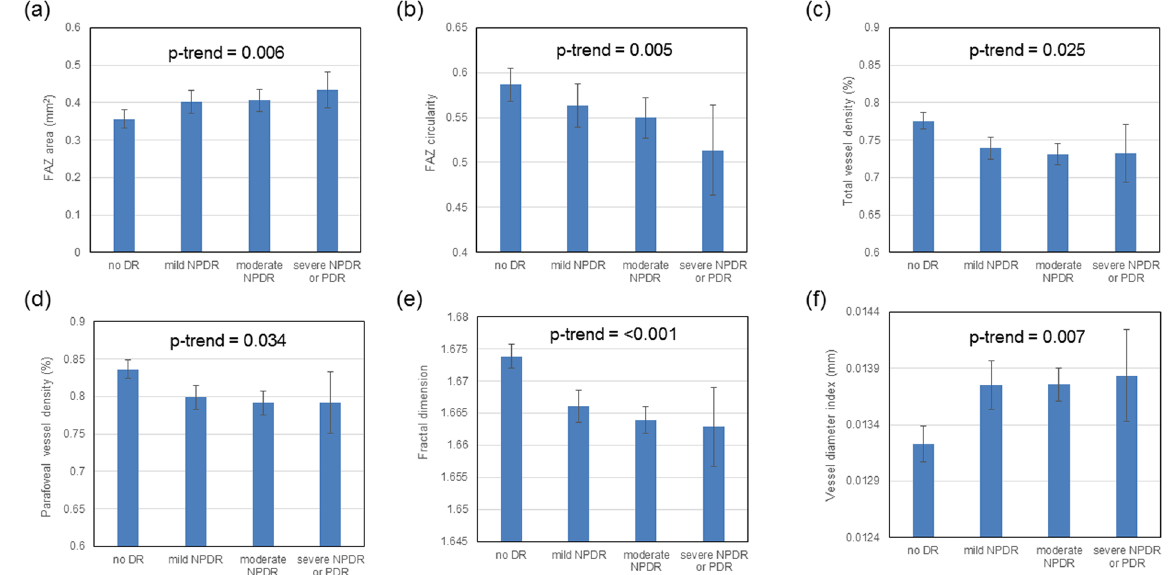
Figure 1. Associations between ( a ) foveal avascular zone (FAZ) area, ( b ) FAZ circularity, ( c ) total vessel density, ( d ) parafoveal vessel density, ( e ) fractal dimension, and ( f ) vessel diameter index with diabetic retinopathy severity. P-trend represents the trend across four increased DR severity categories. Vertical bars indicate 95% confidence